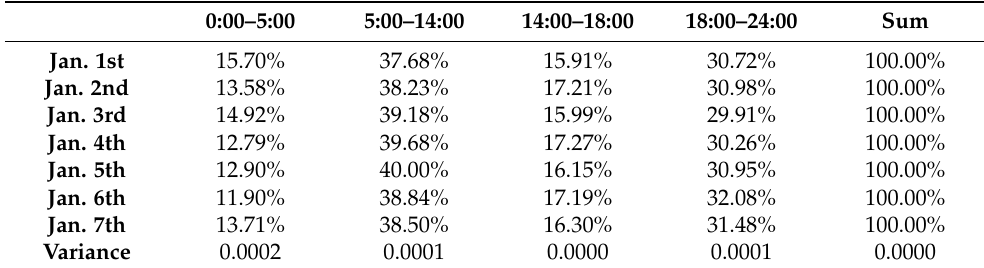
Table 2. Proportion of water consumption in four